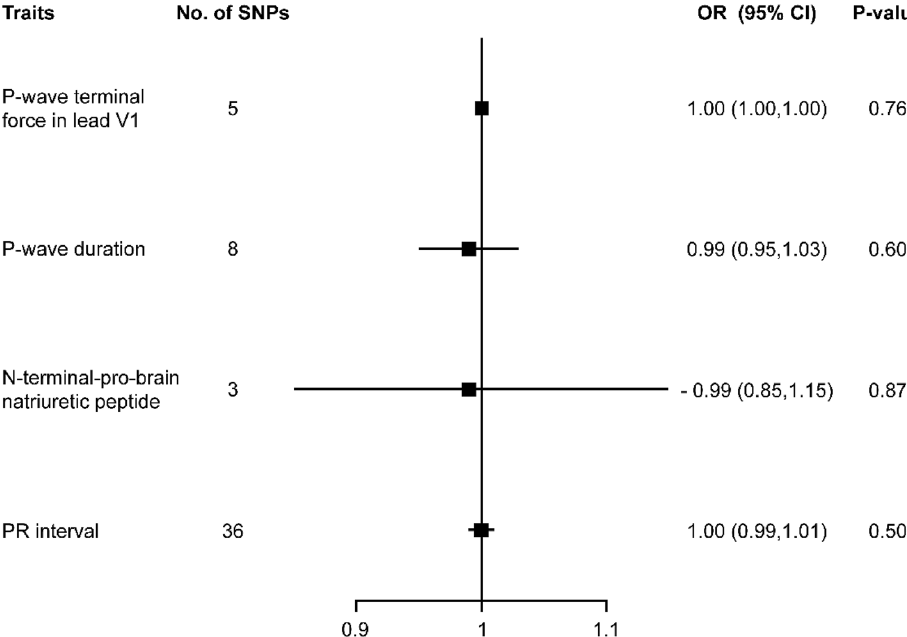
Figure 2. Mendelian randomization for associations between PTFVI, PWD, NT-pro BNP, and PR interval and CES. PTFVI P ‐ wave terminal force in lead V1, PWD P-wave duration, CES cardioembolic